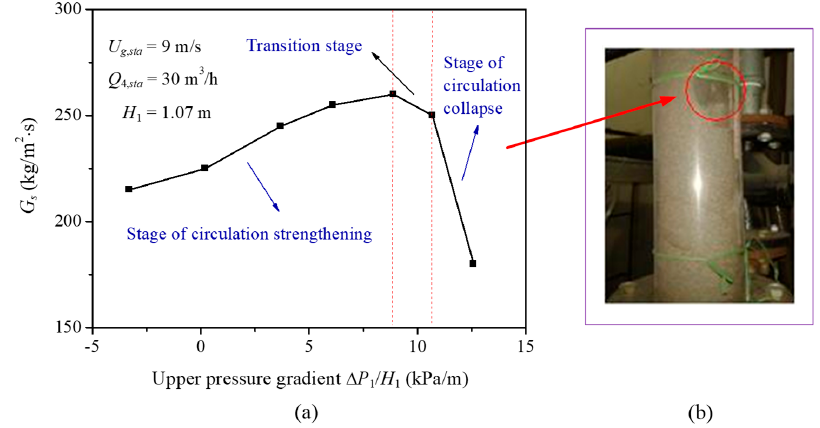
Figure 6. Variations of the solid circulation patterns with the upper pressure gradient: ( a ) variations of the solid circulation flux; and ( b ) snapshot of the state of circulation collapse.